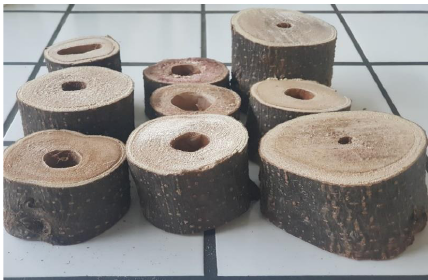
Figure 1. Paulownia tomentosa samples after being cut.